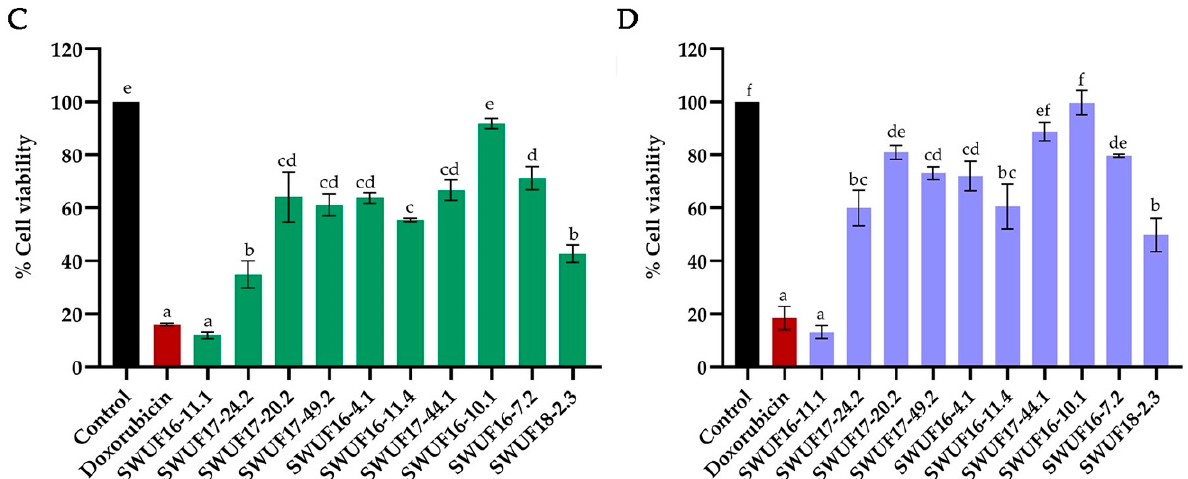
Figure 3. Cytotoxicity of EtOAc extracts of Xylaria spp. against four different cell lines at concentration of 100 µg/mL. ( A ) A549. ( B ) HepG2. ( C ) HeLa. ( D ) PNT2. Data expressed as means ± standard deviation. Means within each graph with different letters (a–g) differ significantly ( p < 0.05).